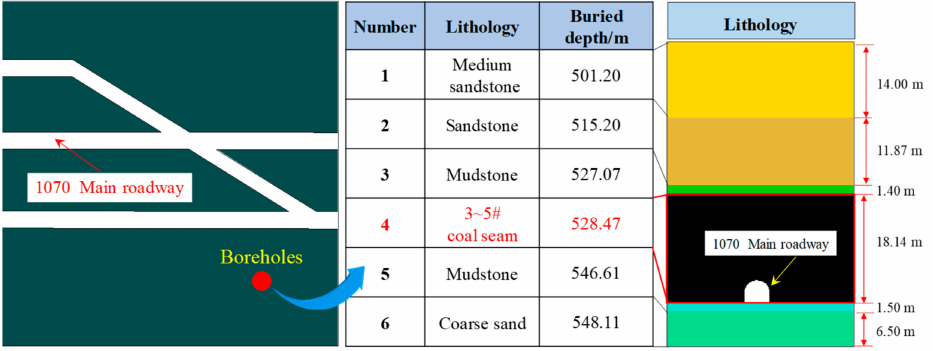
Figure 3. Rock stratum of the borehole near 1070 main